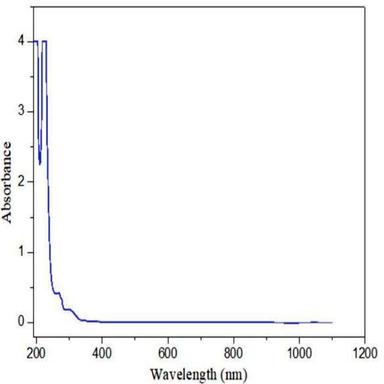
Absorbance spectrum of G4C3NBM.